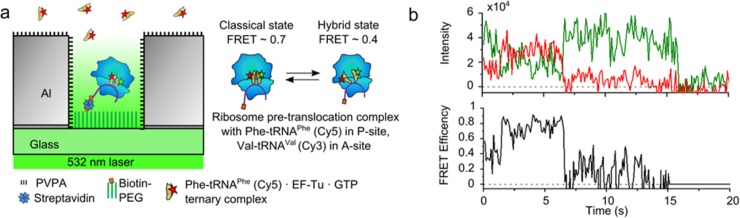
Application of devices to tRNA-tRNA FRET.(a) Schematic cartoon of ribosomes immobilized in an Al ZMW well via biotinylated mRNA, with FRET between Phe-tRNAPhe(Cy5) in the ribosomal P-site and Val-tRNAVal(Cy3) in the A-site. The ribosomes were illuminated by 532 nm laser light, in the presence of 500 nM Phe-tRNAPhe(Cy5)·GTP·elongation factor-Tu (ternary complex) in solution. (b) Example FRET trace from a ribosome transitioning from the low FRET hybrid state to the high FRET classical PRE-translocation state before photobleaching of Cy5 at 7 s followed by photobleaching of Cy3 at 15 s.